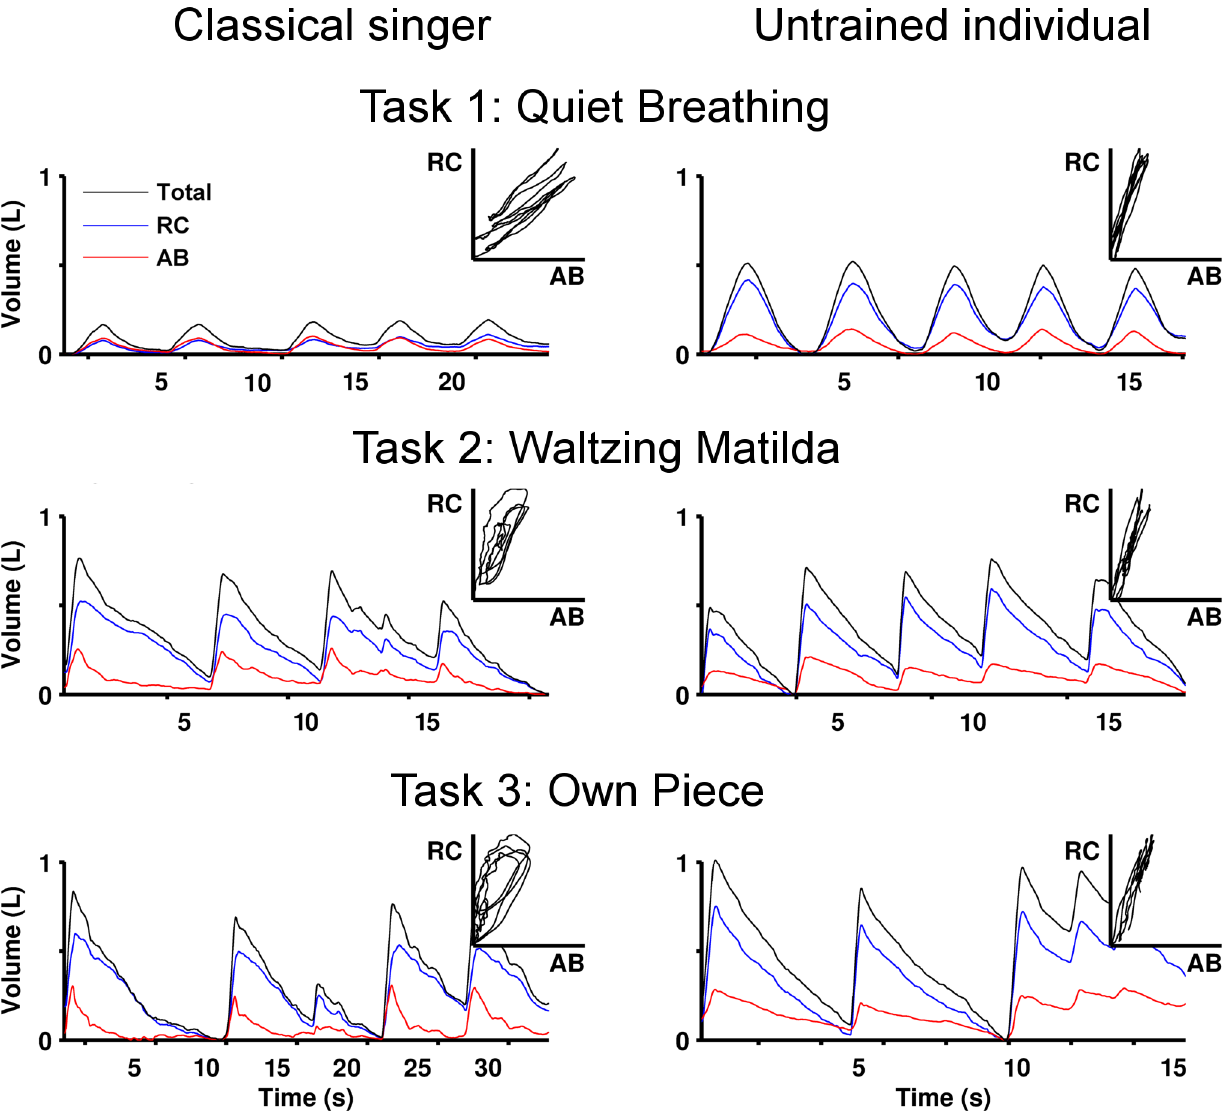
Fig 3. Representative recordings of rib cage (RC), abdominal (AB) and total lung volumes of one classical singer and one untrained individual performing each experimental task. Volume waveforms are shown for five consecutive breath cycles, with the corresponding Konno-Mead plots representing the coordination between AB and RC movements (in the x- and y-axis respectively).